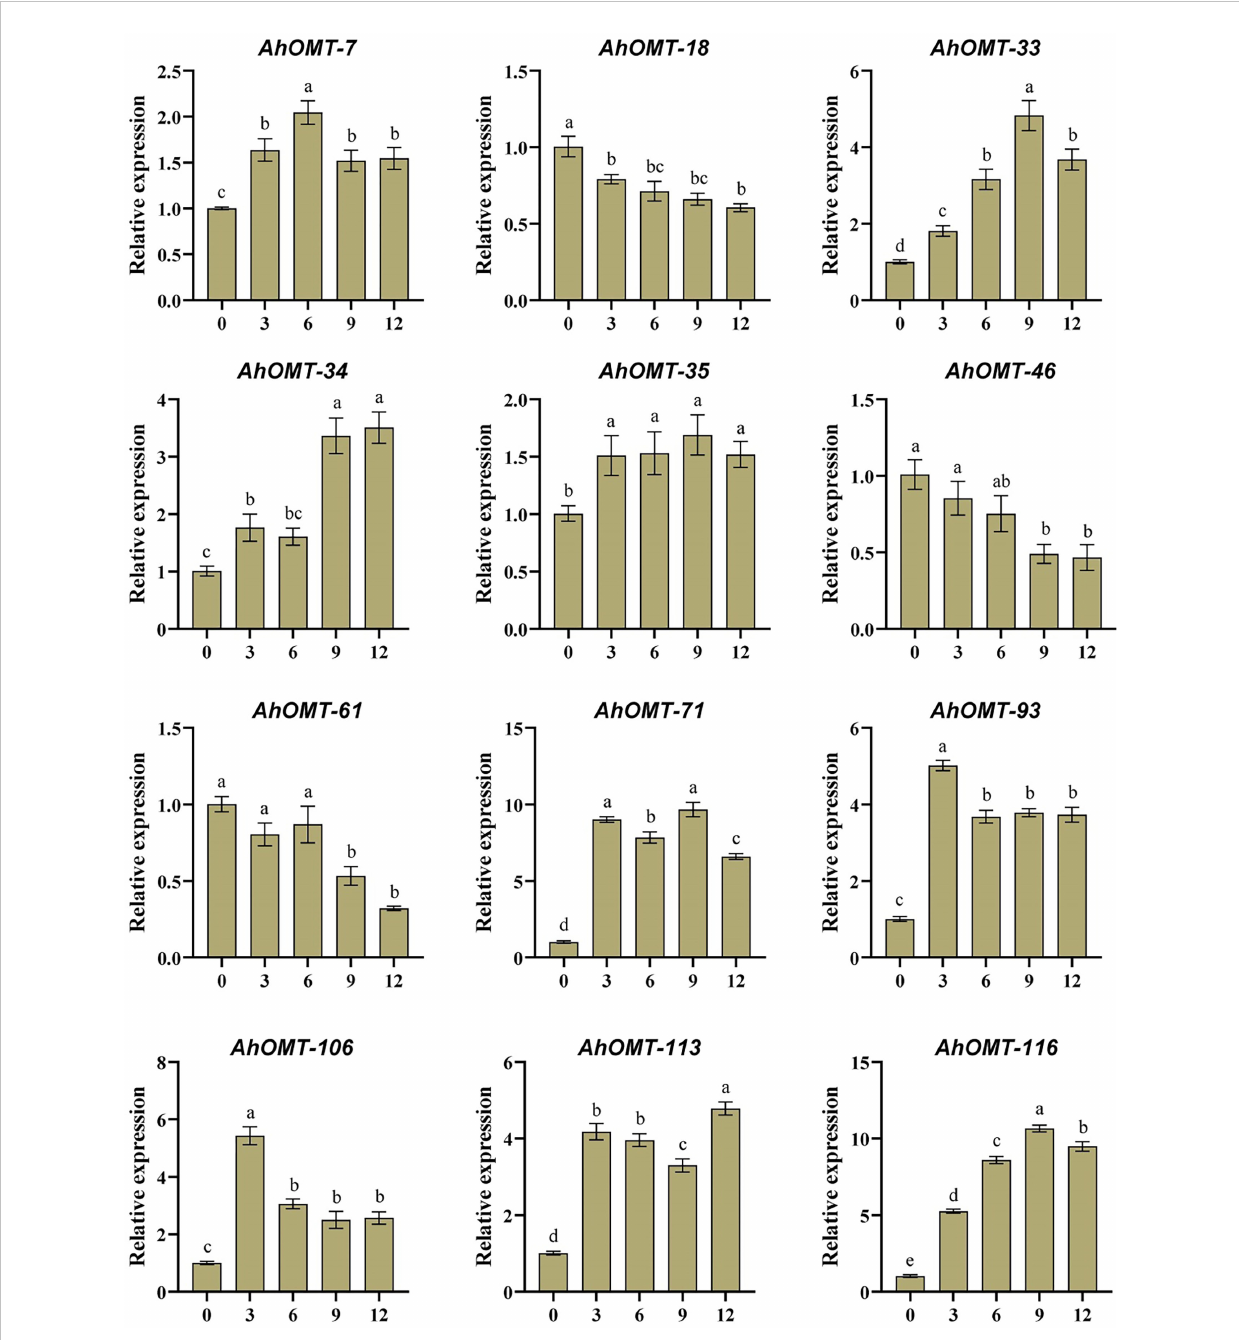
FIGURE 15 Expression pro fi ling of AhOMT genes in response to cold stress. Mainly AhOMT genes recorded increased expression under cold stress, while some genes were down-regulated. a, b, and c represents the signi fi cance levels among expression at different time